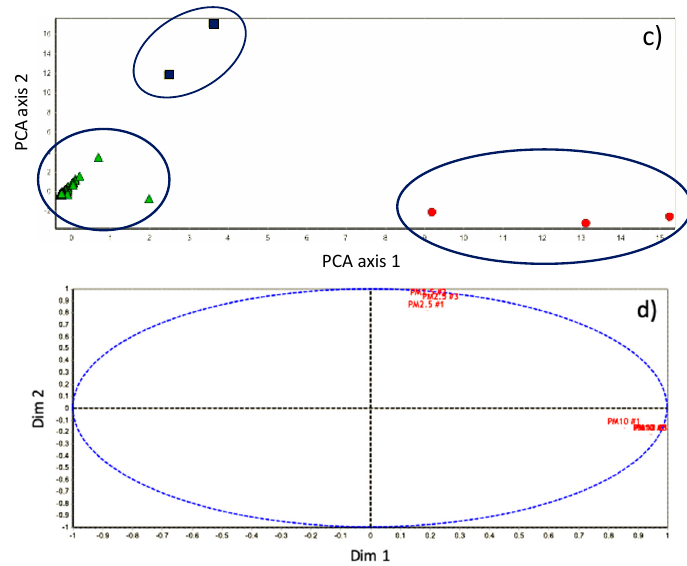
Figure 10. Main results of the chemometric approach to overall the data—Principal Component Analysis (PCA) ( a ) and correlation scatter ( b ) plots obtained in downtown Civitavecchia, U; PCA ( c ) and correlation scatter ( d ) plots obtained in sampling at the suburban area, UB (red: cluster #1; green: cluster #2; blue: cluster #3).